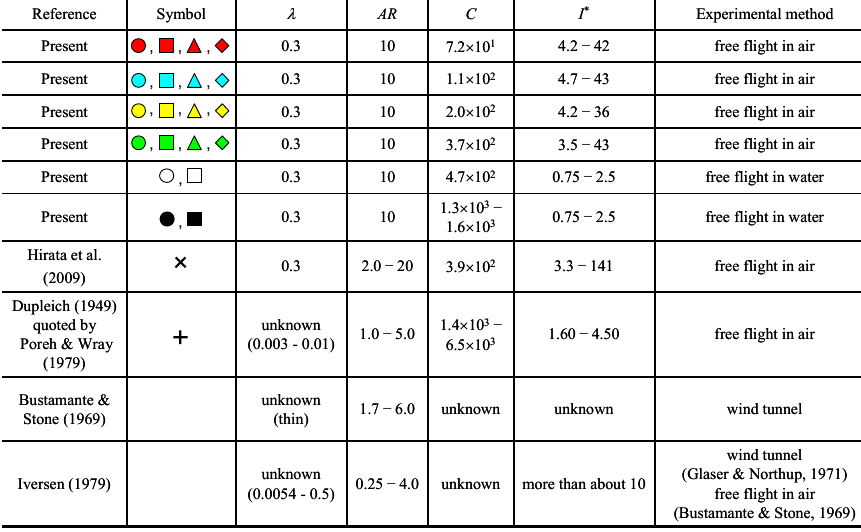
Table 1 Parameters and the corresponding symbols in Figs. 5 − 15.